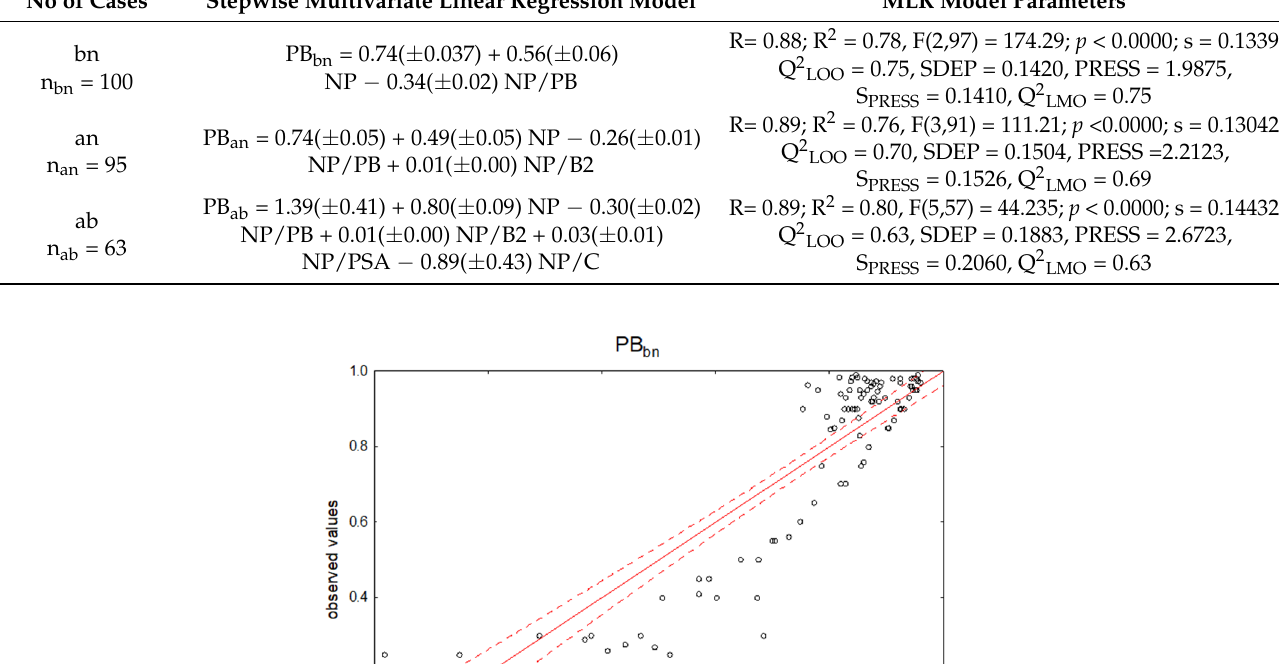
Table 3. MLR models for combined groups of APIs: (bn), (an) and (ab) using NP TLC retention data .